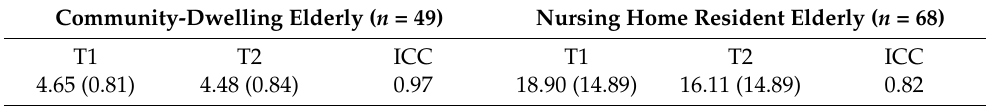
Table 1. Means, standard deviations and inter-class correlation